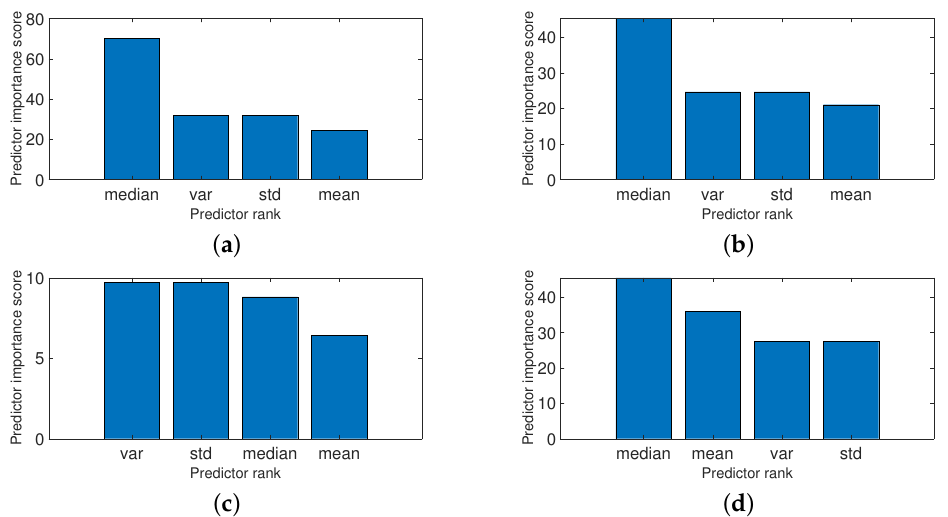
Figure 13. Feature ranking from the raspberries diseases and defects using descriptive statistics. ( a ) Albinism. ( b ) Fungus-Rust. ( c ) Over-ripeness. ( d ) Peduncle.